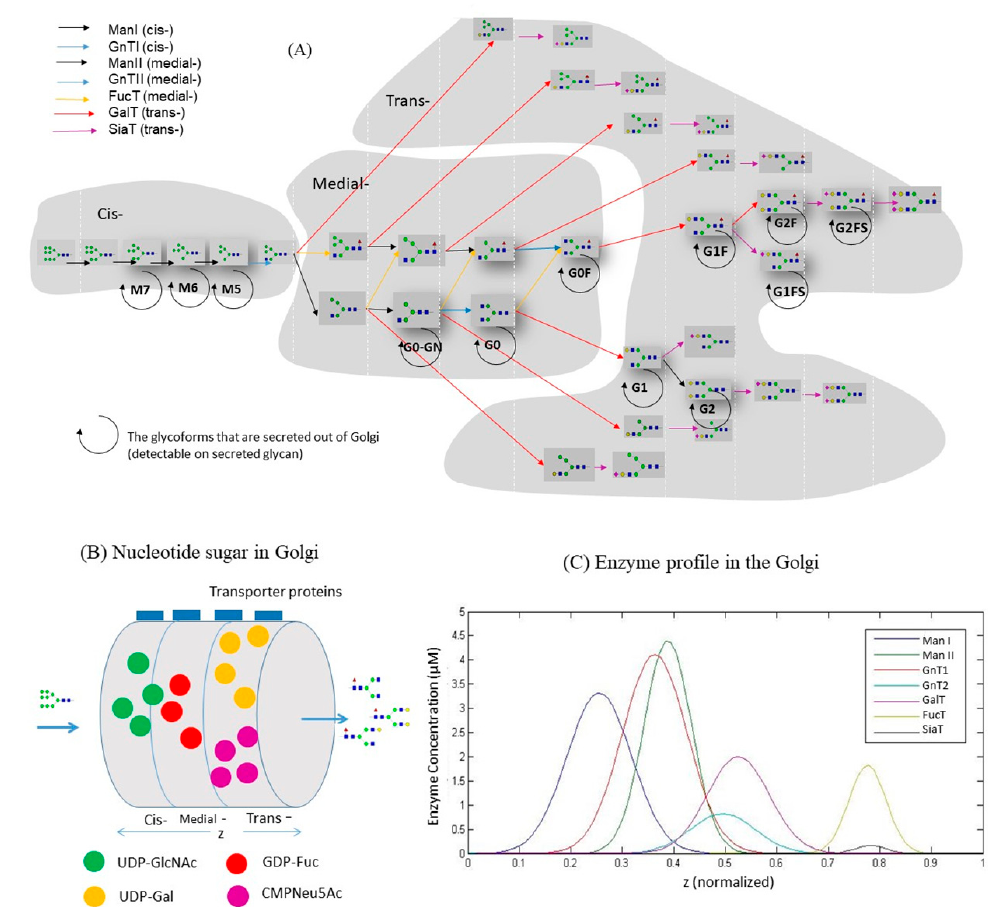
Figure 3. Structure of the kinetic model. ( A ) Reaction network of oligosaccharide evolvement in the Golgi. ( B ) The analog of Golgi as a single plug flow reactor in the model. Nucleotide sugars are transported from cytoplasm to Golgi. ( C ) Distribution profile of glycosylation enzymes in Golgi as adjusted from Reference [27] .